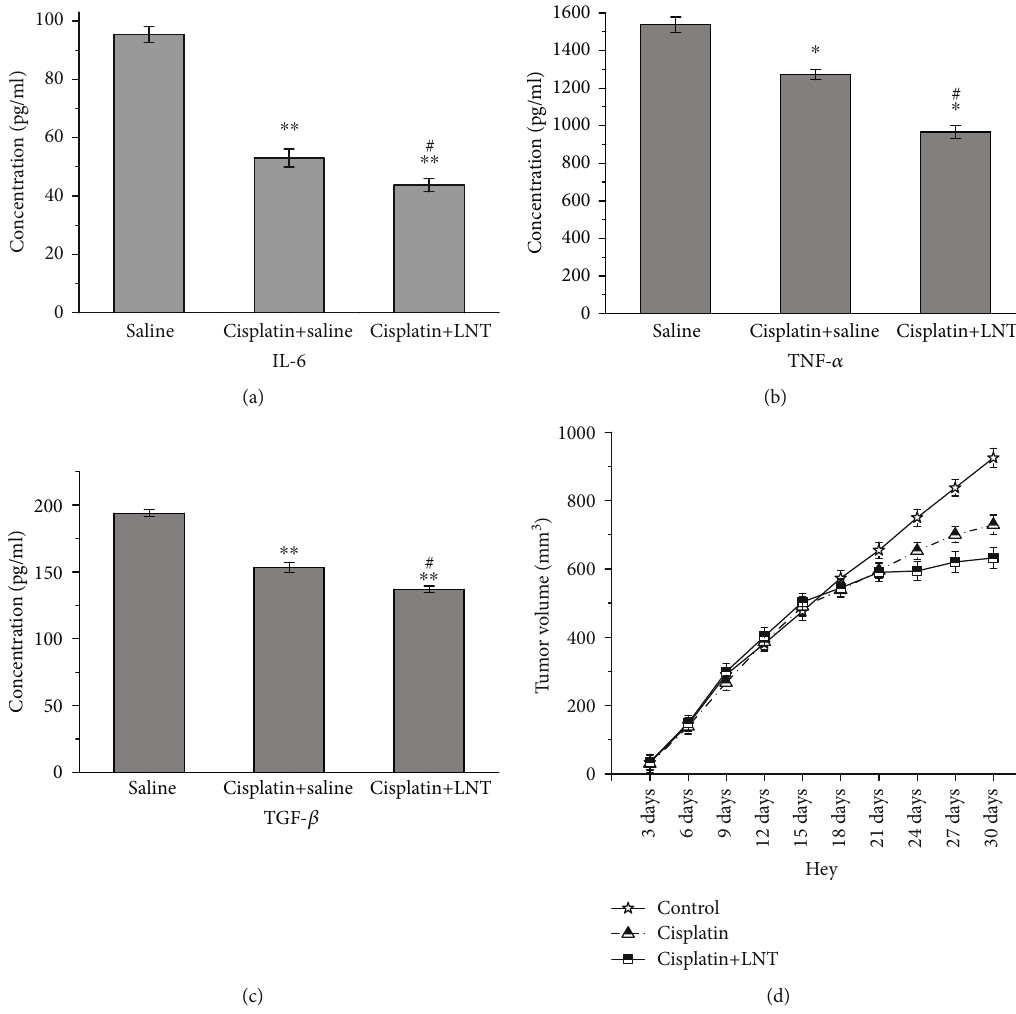
Figure 3: Enhanced inhibitory e ff ect of cisplatin on expressions of IL-6, TNF- α , and TGF- β and tumor growth in mice bearing human ovarian cancer xenograft by combination therapy of lentinan and cisplatin. (a – c) It is enhanced by the combined treatment of lentinan and cisplatin that the expression of IL-6 (a), TNF- α (b), and TGF- β (c) on the serum of mice bearing ovarian cancer induced by cisplatin. (d) It is enhanced by the combined treatment of lentinan and cisplatin that the inhibition of tumor growth of mice bearing ovarian cancer by cisplatin. ∗ P < 0 : 05 , ∗∗ P < 0 : 01 , signi fi cantly di ff erent from the saline group. # P < 0 : 05 , ## P < 0 : 01 , signi fi cantly di ff erent from the cisplatin+saline